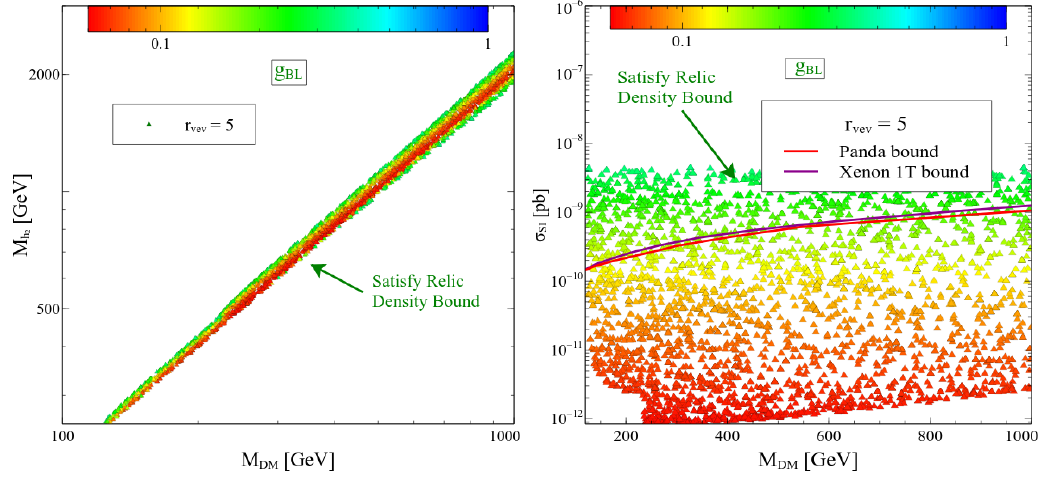
Figure 9 . Left (right) panel: scatter plot in the M DM the DM relic density bound. The parameters range have been shown in the table 2 and other parameters have been kept (cid:12)xed at r vev = 5, M N M N = M N 0 = 111 : 0 GeV, M h 3 3 h (cid:28)e = 1 : 34, sin (cid:12) = 0 : 07, (cid:1) M = M 2